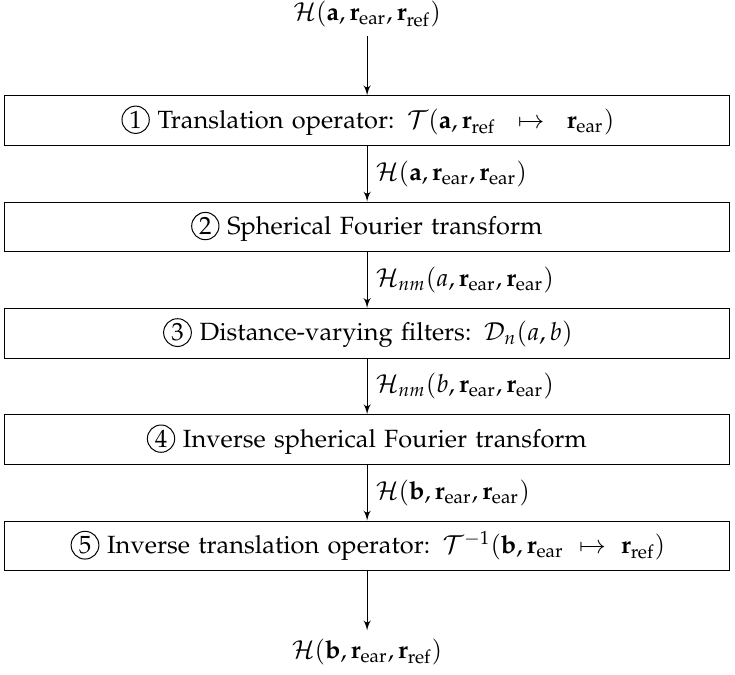
Figure 3. Near-field HRTF synthesis with ear centering based on translation